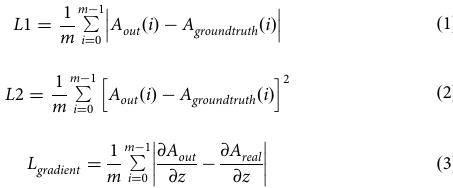
where m, A out , and A ground truth are the sizes of the A-scans (2048 in our study), reconstructed A-scans, and ground truth A-cans, respectively. The adversarial loss included in the generator loss and the discriminator loss are de fi ned as binary cross entropy (BCE), represented as follows: (cid:3) BCE x ; y